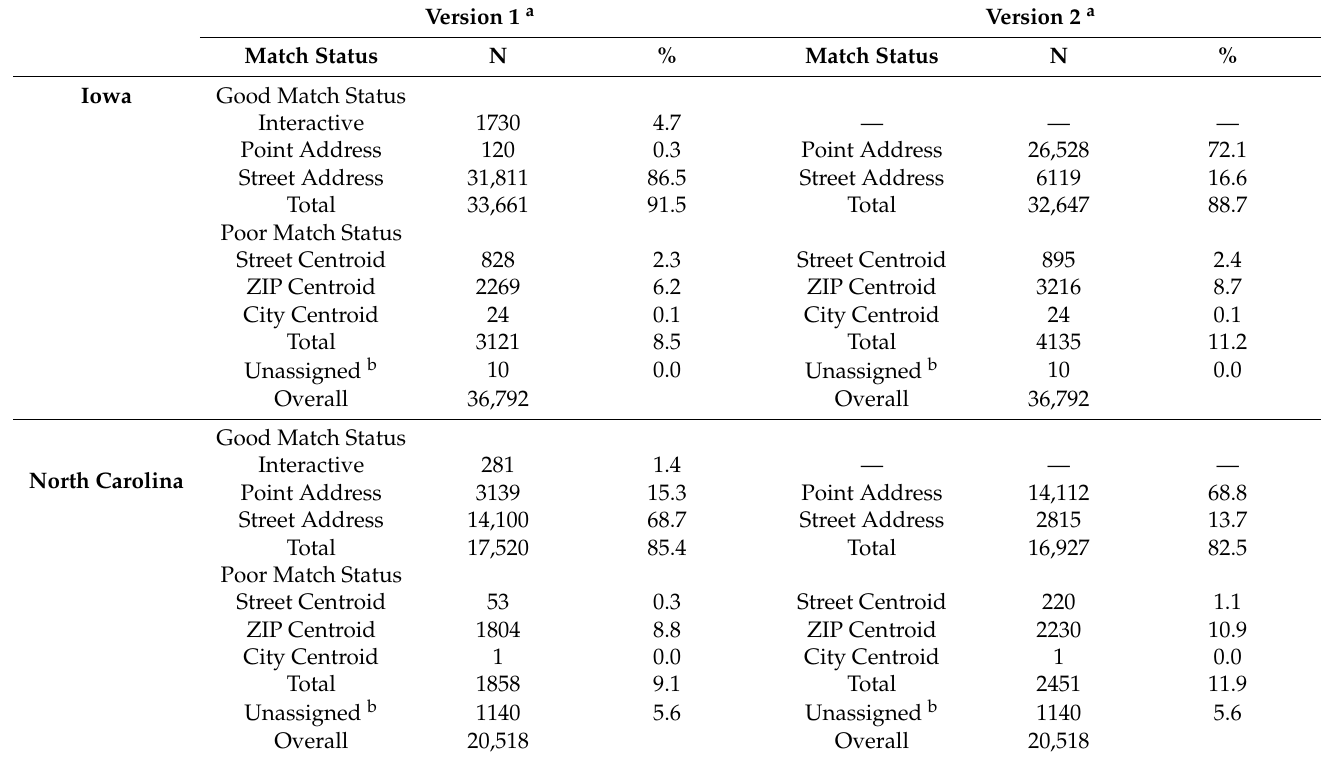
Table 1. Geocode match status (number [N], percentage [%] for enrollment addresses, Agricultural Health Study applicators in Iowa (n = 36,792) and North Carolina (n =